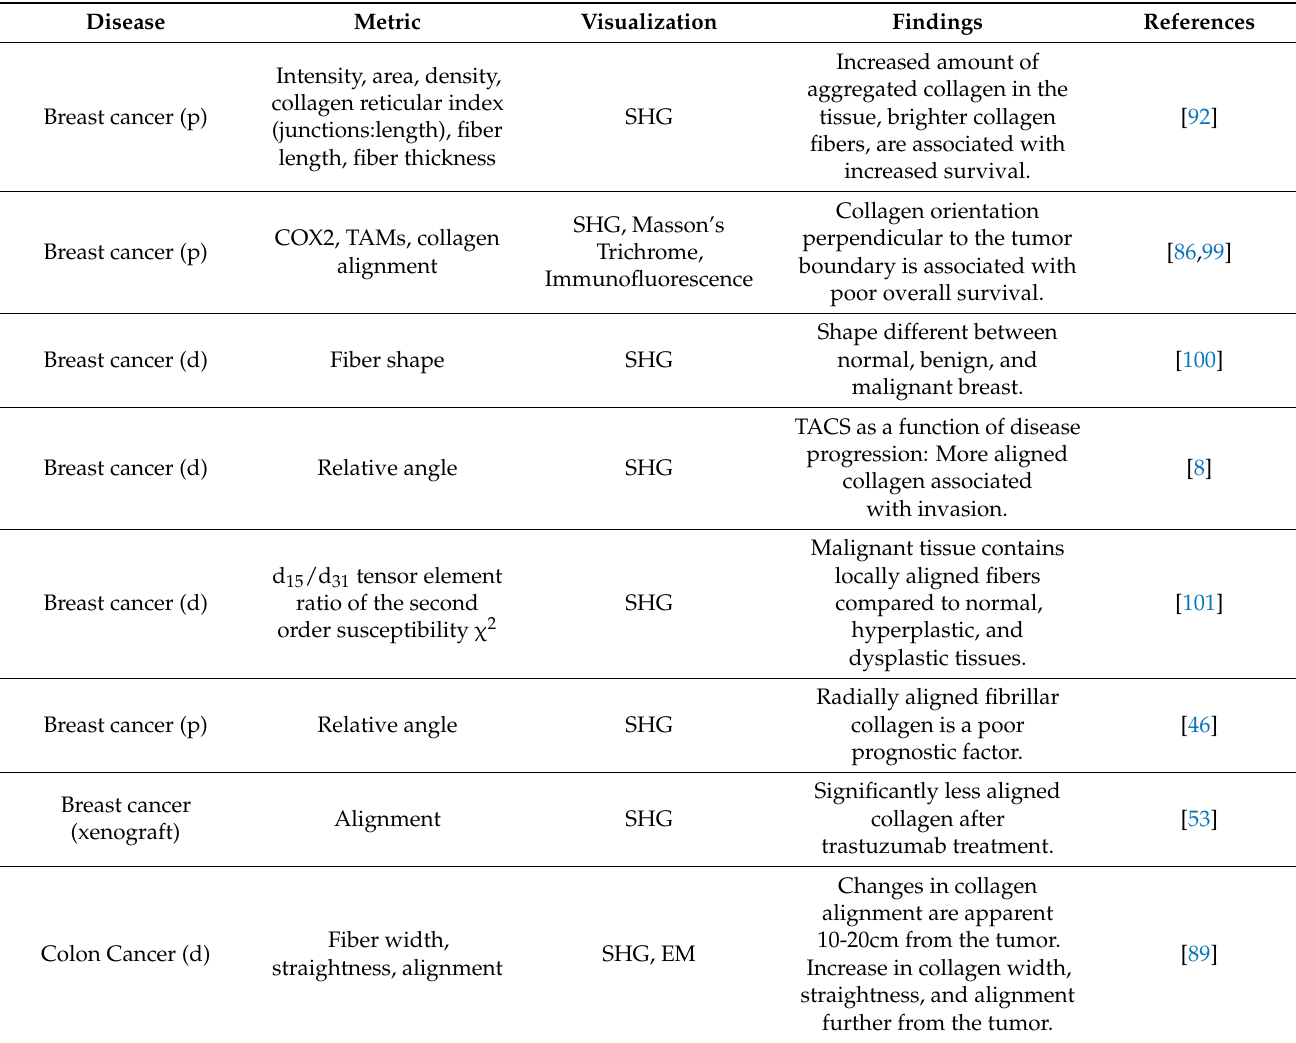
Table 1. Overview of Published Collagen Fiber Organization Studies in